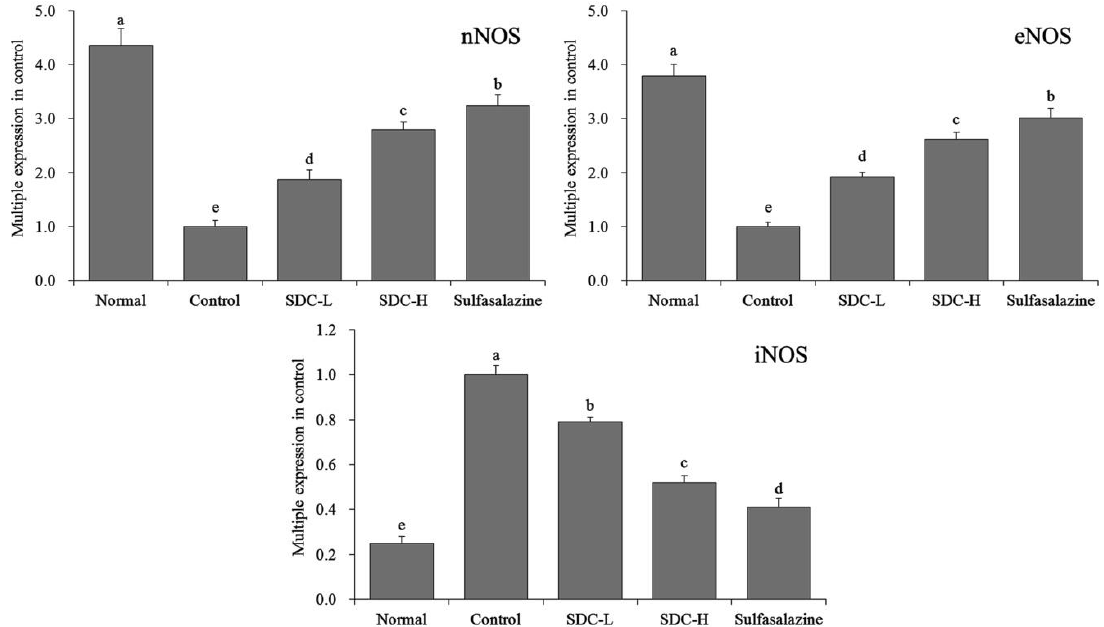
Figure 12. mRNA expression levels of neuronal nitric oxide synthase (nNOS), endothelial nitric oxide synthase (eNOS), and inducible nitric oxide synthase (iNOS) in the colon tissue of mice. Values represent the mean ± standard deviation. a–e Mean values with different letters in the same bars indicate significant difference ( p < 0.05). SDC-L: 2 g/kg Shuidouchi extract treatment; SDC-H: 4 g/kg Shuidouchi extract treatment; Sulfasalazine: 20 mg/kg sulfasalazine treatment.